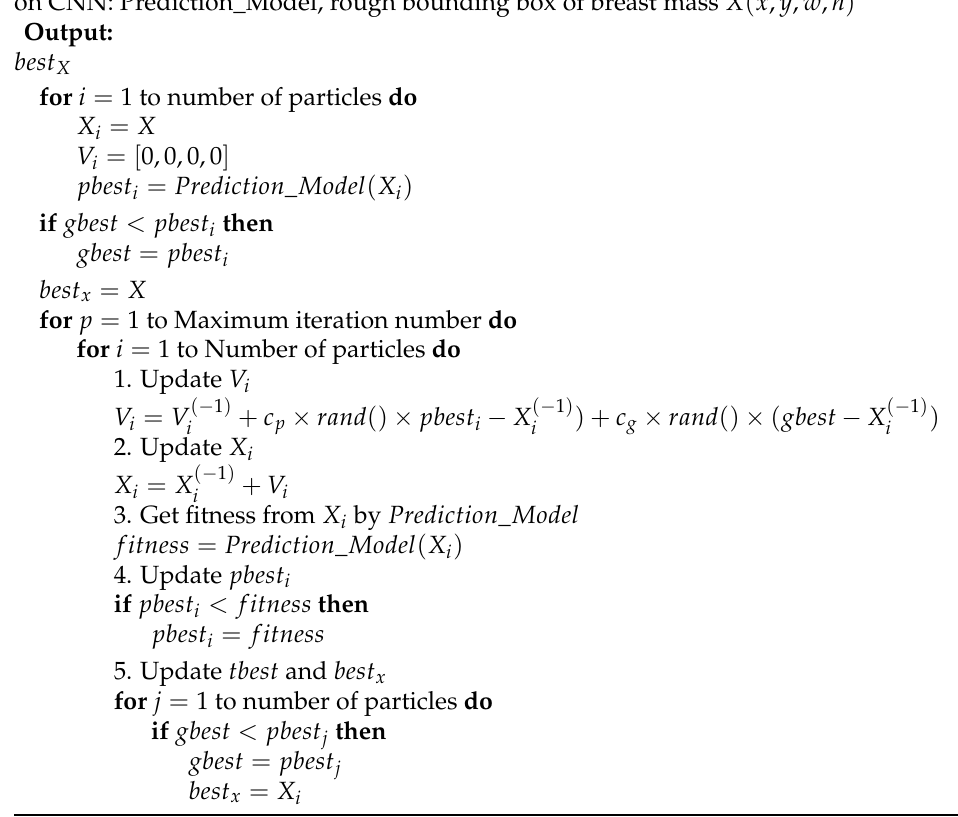
Algorithm 1 PSO for breast mass bounding box